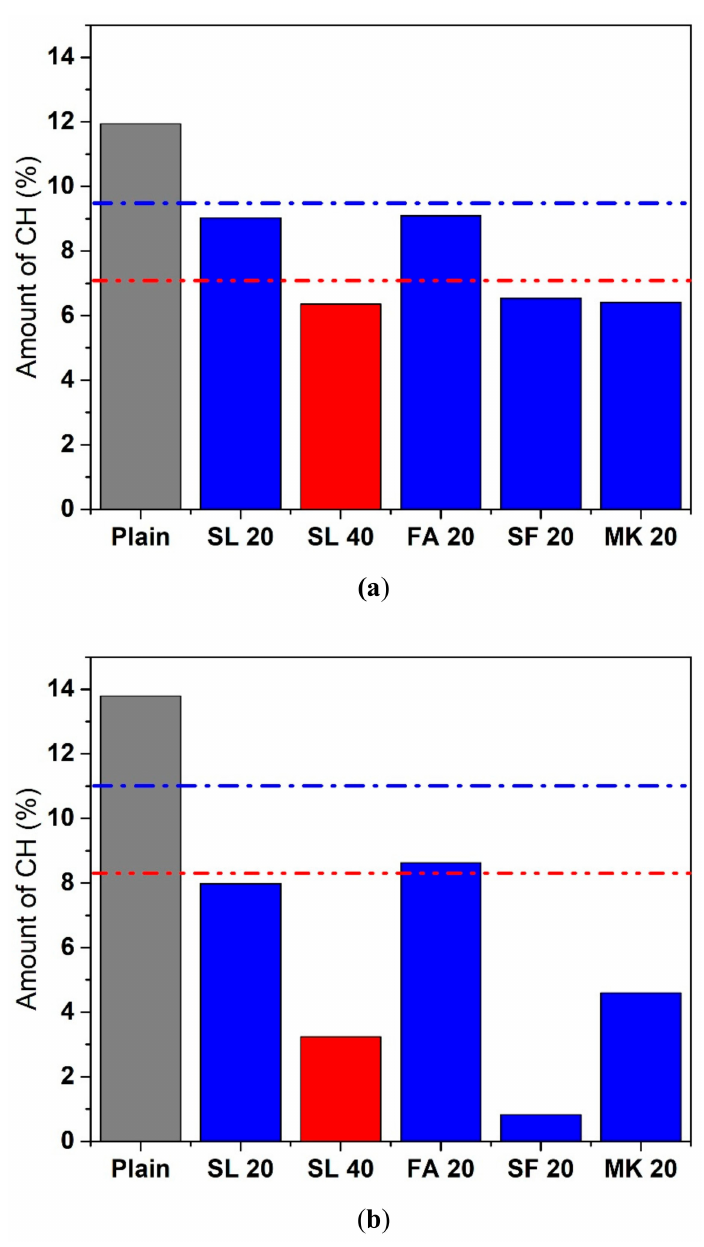
Figure 9. Amount of calcium hydroxide in cement pastes after 7 days ( a ) 23 ◦ C and ( b ) 50 ◦ C (the blue and red dash-dot lines indicate 80% and 60% of the calcium hydroxide amounts in the plain cement paste, respectively. The difference in the calcium hydroxide amounts determined from repeat specimens was generally